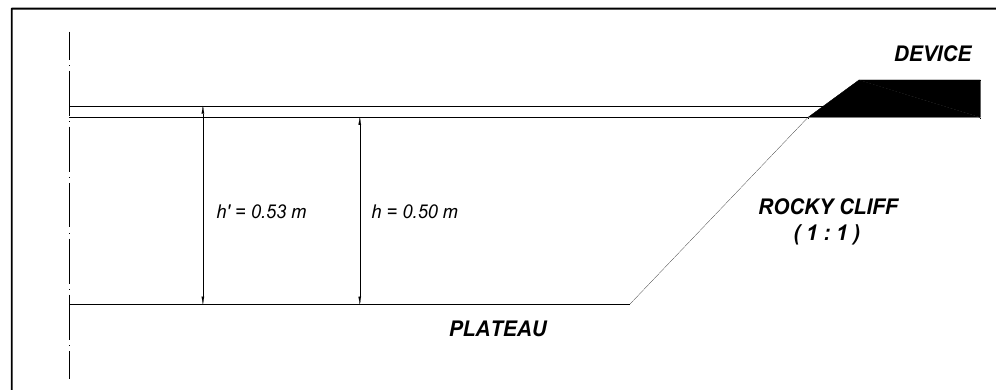
Figure 3. Cross section of the